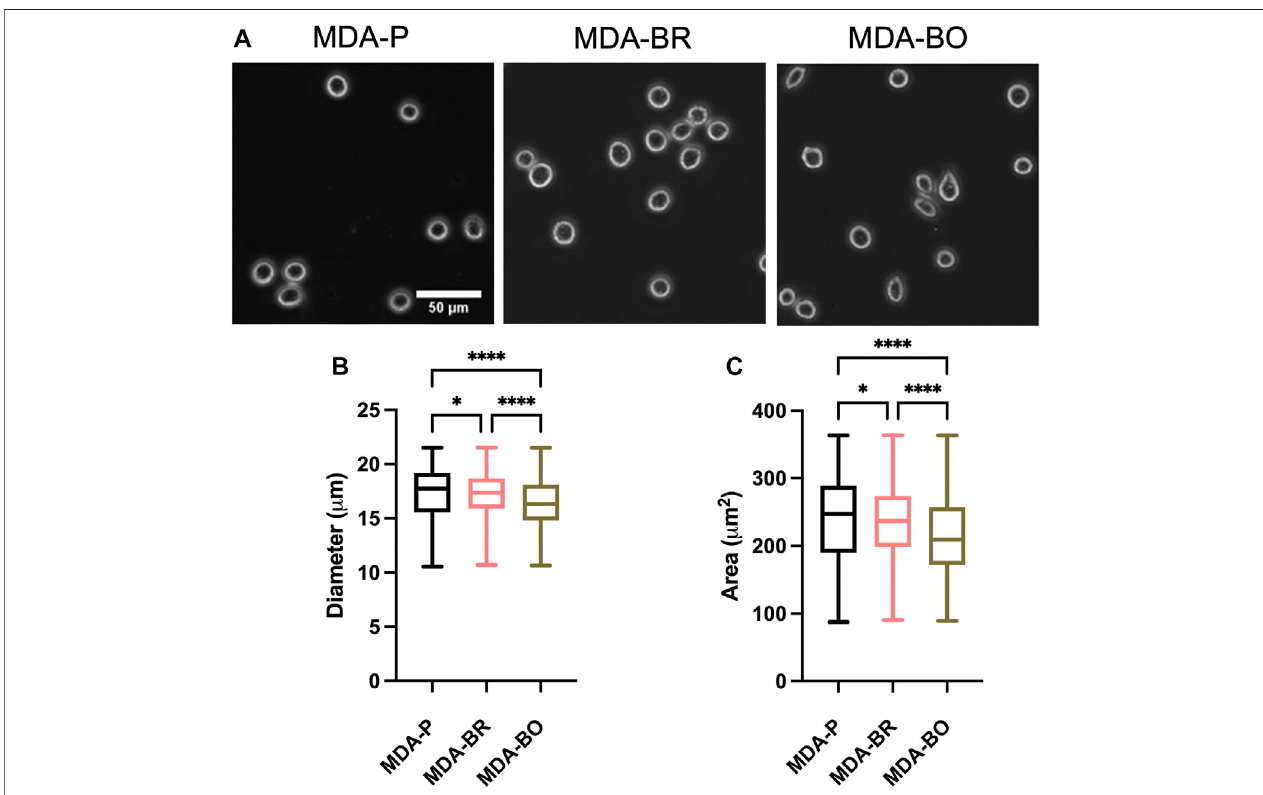
FIGURE 1 | Morphology of suspended parental, brain-seeking, and bone-seeking MDA-MB-231s. (A) Phase contrast images of MDA-P, MDA-BR, and MDA-BO cells in suspension. Scale bar represents 50 μ m. (B) Diameter measured by ImageJ. (C) Area of suspended MDA-P, MDA-BR, and MDA-BO cells based on diameter. Box and whisker plots represent the minimum and maximum data points, the median, and the interquartile range. * indicates p < 0.05. **** indicates a p < 0.0001. Each column of data is from N > 1,277 cells pooled from at least 3 independent experiments. The data in this fi gure were tested for normality using the D ’ Agostino and Pearson test and found to be not normally distributed. A Kruskal Wallis test and a Dunn ’ s multiple comparison test was performed to determine signi fi cance.